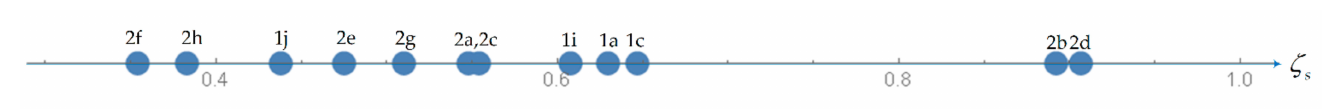
Figure 2. Handling Qualities for the short-period mode.